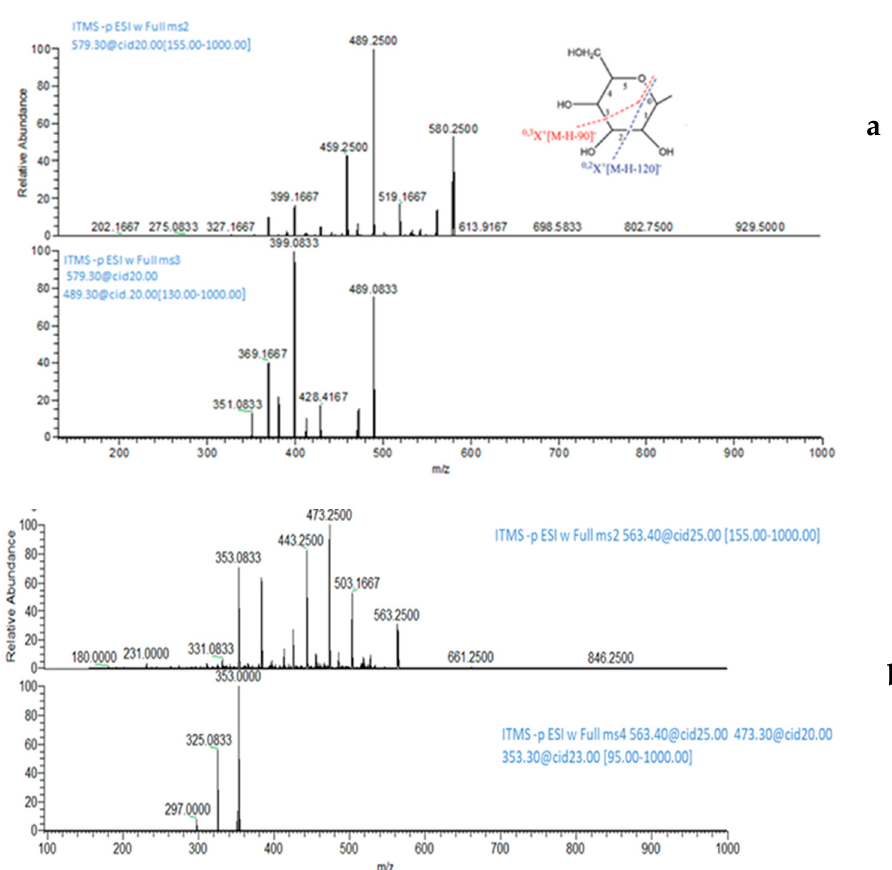
Figure 3. MS 2 and MS 3 spectra ( a ) of carlinoside/isocarlinoside/neocarlinoside ( 10 ) and MS 2 and MS 4 spectra ( b ) of isoschaftoside ( 11 ). All MS n spectra were recorded at the optimized collision energy using wideband activation. The fragmentation of the glycosidic moiety, originating the losses of 90 and 120 mass units, is also shown. Table 1. C -glycosylated flavonoids detected in Lisosan ® G by MS n